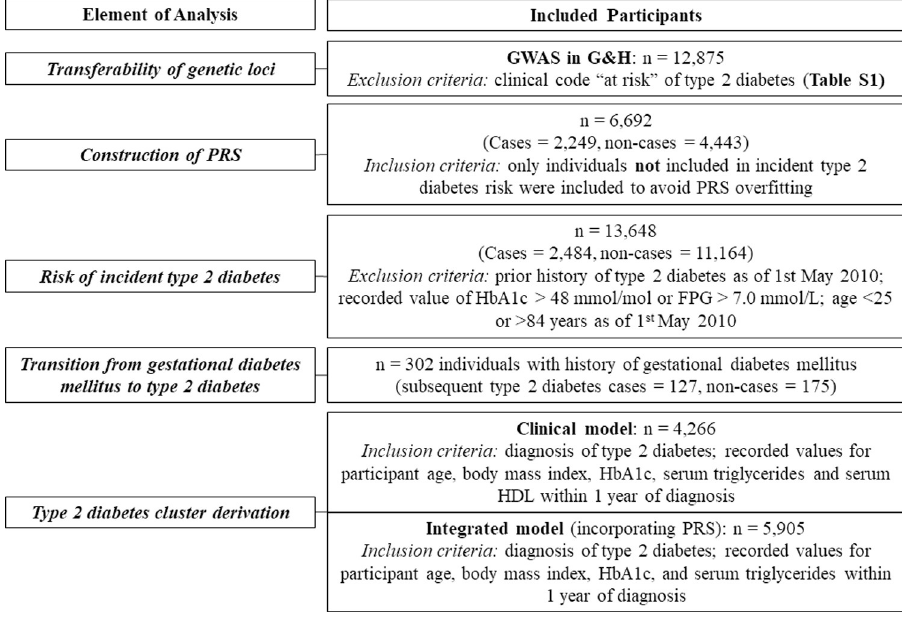
Fig 1. Summary of analyses in study. FPG, fasting plasma glucose; GWAS, genome-wide association study; G&H, Genes & Health; HDL, high-density lipoprotein; PRS, polygenic risk score.